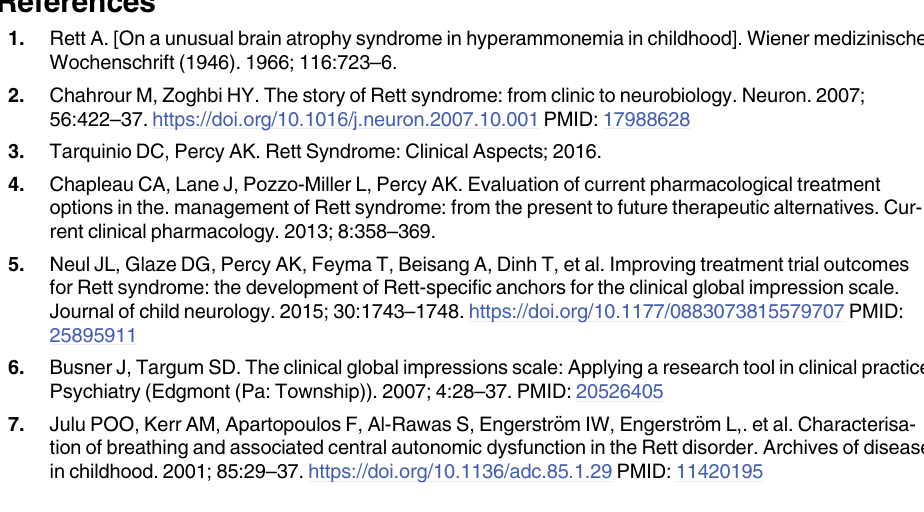
popularity ( ρ ) scores for these five features. The individual subplots correspond to